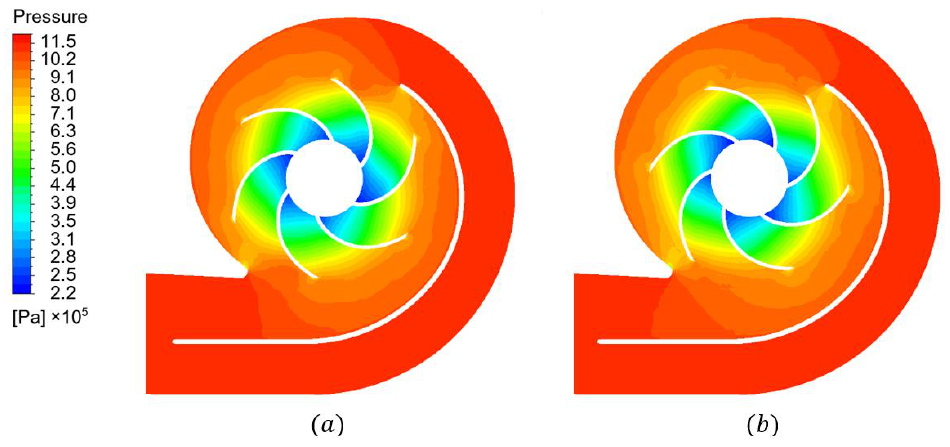
Figure 16. Pressure distribution at midspan between the impeller hub and shroud. ( a ) uniform pressure contour when blades are not aligned with the cutwater. ( b ) pressure side experiencing lower pressure than the suction side on blades aligned with the cutwaters.